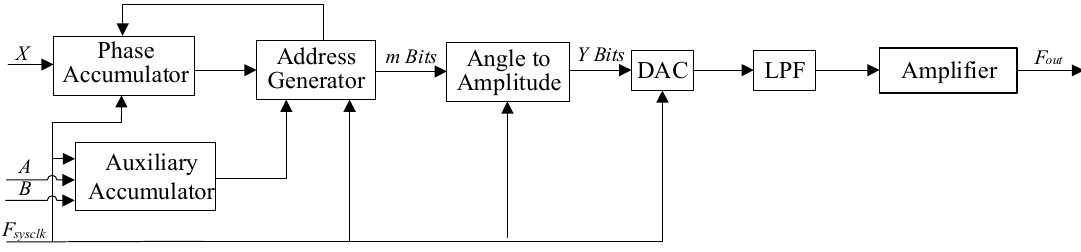
Figure 3. Functional block diagram of new DDS method.